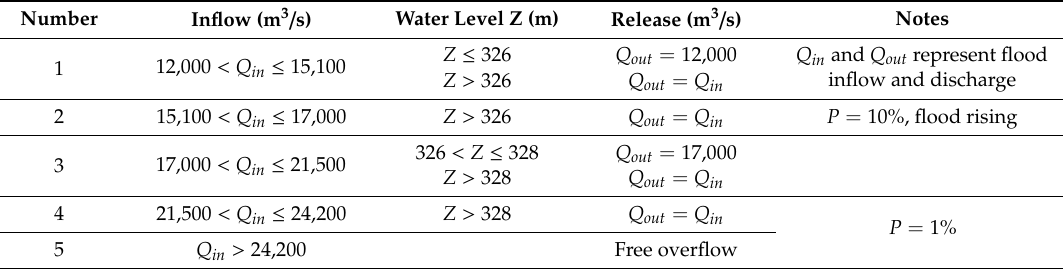
Table 1. The Routine Operation Rules of Ankang Reservoir for CO.